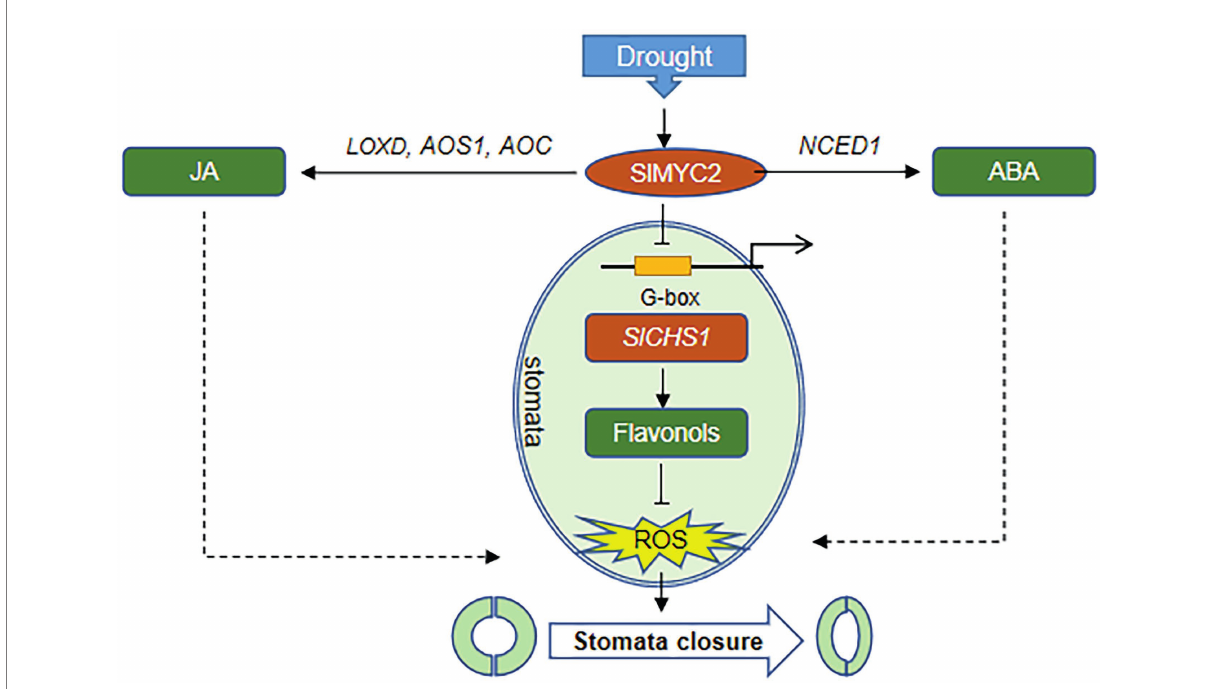
FIGURE 10 The proposed mechanism by which SlMYC2 responds to drought stress and regulates stomatal closure. In response to drought stress, SlMYC2 expression is induced, which promotes the accumulation of JA and ABA by activating the expression of hormone biosynthetic genes. SlMYC2 also interacts with the SlCHS1 promoter to repress its expression, resulting in a reduced flavonol content and increased ROS levels in guard cells. Solid arrows represent positive regulation proven in this study, and dashed arrows represent positive regulation proven in other studies. Blunt arrows represent negative